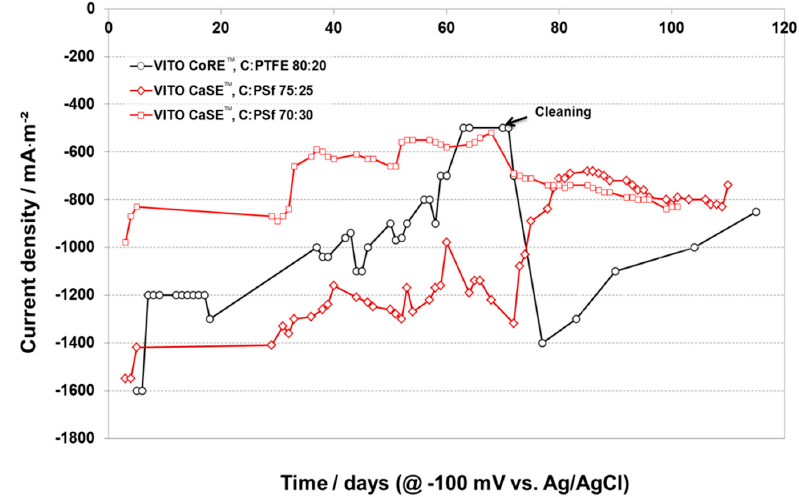
Figure 5. Performance of a VITO CaSE™ electrode (C:PSf 70:30) as a function of time at constant voltage − 100 mV vs. Ag/AgCl.